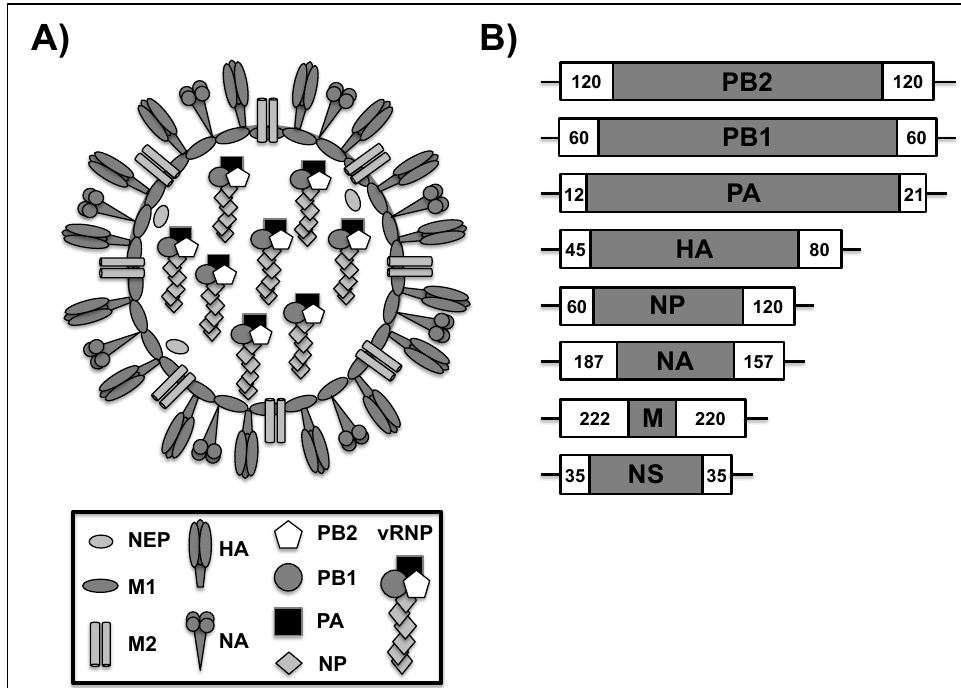
Figure 1. Influenza A virus (IAV) virion structure and genome organization. A) Virion structure: IAV is an eight-segmented, negative-sense, single-stranded RNA enveloped virus surrounded by a lipid bilayer that contains three viral glycoproteins: hemagglutinin (HA), responsible for binding to sialic acid receptors, entry into the cell and fusion of the viral envelop with the endosome; neuraminidase (NA), which removes sialic acids, allowing for viral release from infected cells; and, the ion channel matrix 2 (M2) protein, which is responsible for the acidification of the virion following endocytosis, and viral assembly. Under the viral envelope, there is a protein layer that is made of the matrix 1 (M1) protein, which is involved in virion assembly and budding. The nuclear export protein (NEP) is found inside the viral particle and it is required for the nuclear export of the eight viral ribonucleoprotein (vRNP) complexes from the nucleus to the cytoplasm at the late stages of viral replication. The vRNP complexes, which are present in the core of the virion, are made of the negative-sense, single-stranded viral (v)RNAs packed by the viral nucleoprotein (NP) and the three subunits (PB2, PB1, and PA) of the RNA-dependent RNA polymerase (RdRp) complex that are responsible for viral RNA genome replication and gene transcription in the nuclei of infected cells. IAV proteins and their schematic representation are shown at the bottom. B) Genome organization: The IAV genome is made of eight single-stranded, negative-sense, vRNA segments (PB2, PB1, PA, HA, NP, NA, M, and NS). White boxes represent packaging signals that are responsible for the selective packaging of each vRNA segment into the virion. Numbers represent the nucleotide lengths of each of the 3′ and 5′ packaging signals in each of the vRNAs. Each vRNA is flanked by the 3’and 5´ non-coding regions (NCRs, black lines) recognized by the viral RdRp for viral genome replication and gene transcription.